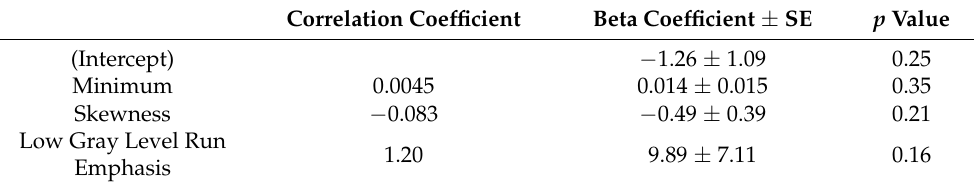
Table 2. Logistic regression model of radiomic features to predict good lymph node response.